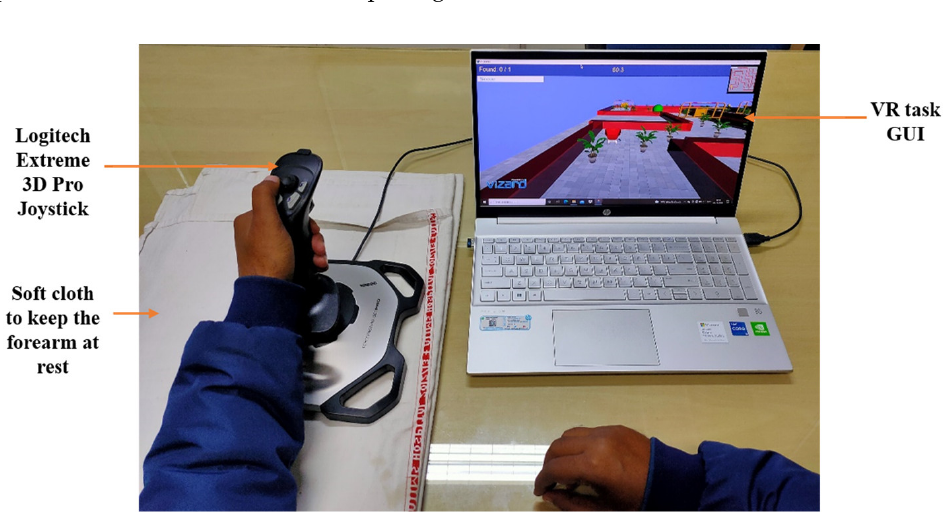
Figure 1. Timeline with relevant data from the episodes of care and clinical assessment scores ob- tained at the time of enrollment. * Details in Supplementary Material.